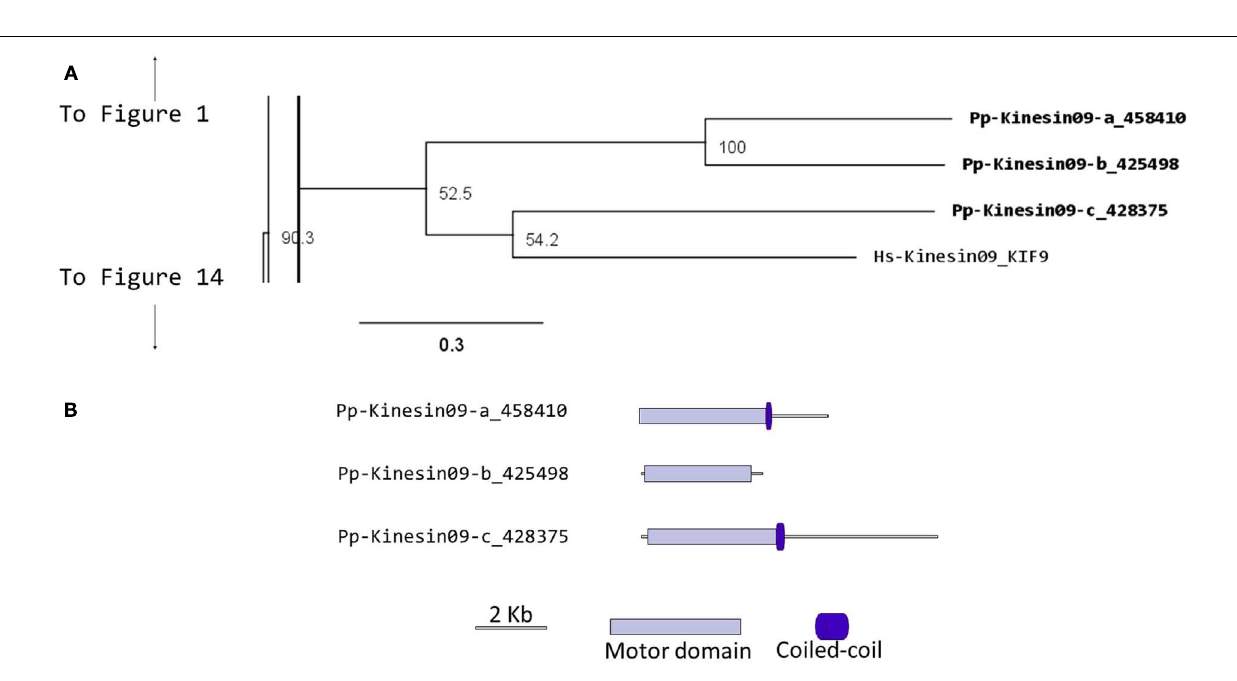
FIGURE 9 | (A) Sub-region of the phylogenetic tree based on their motor domain showing kinesin 9s.The amino acid sequences of the motor domain were aligned using ClustalW and the phylogenetic tree was constructed using the maximum likelihood method (PhyML) and a 1000 bootstrap resampling value. Numbers on the nodes show the statistical support of values above 50%.The scale shows the estimated branch